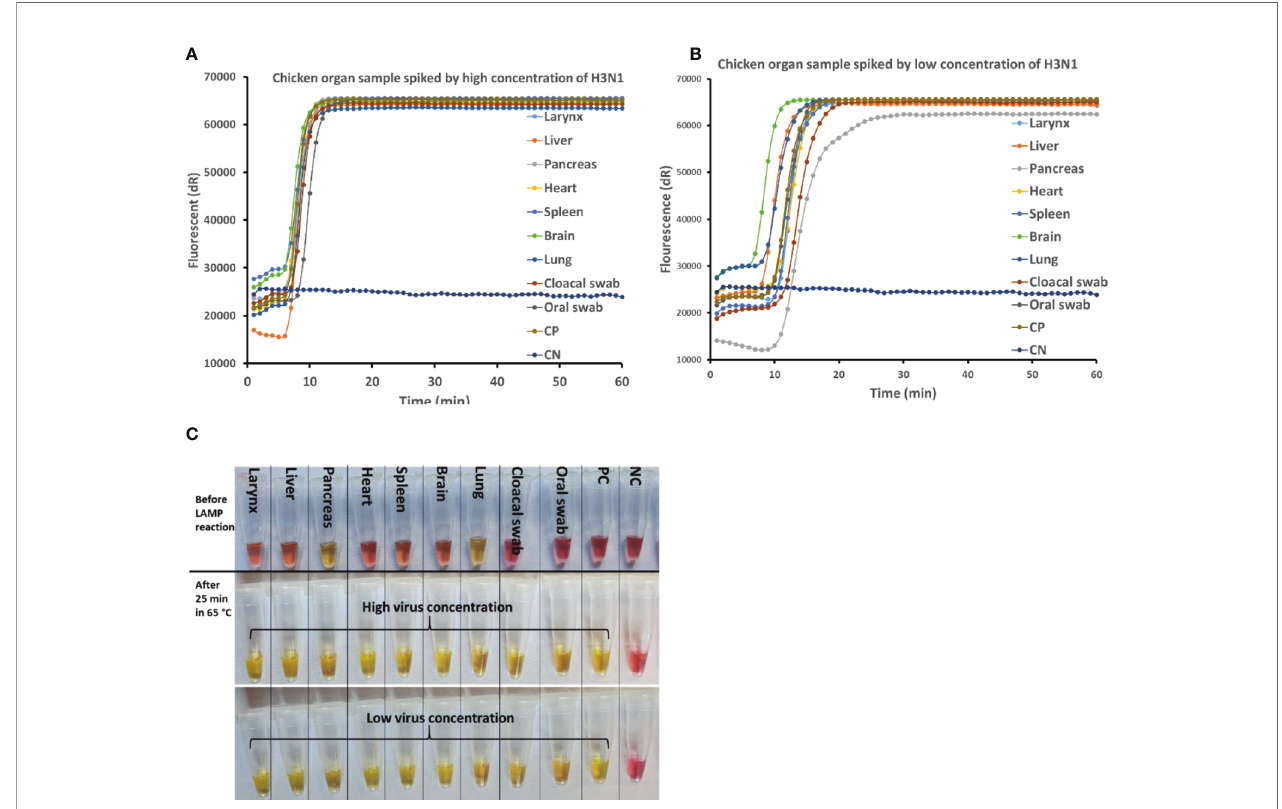
FIGURE 4 | AIV detection in real matrix samples with rRT-LAMP assay and on-site testing method. The real matrix samples (90µL) are spiked with 10 µL of high (10 8.5 EID 50 /mL) and low (10 4.5 EID 50 /mL) concentrations of AIV H3N1. The samples are heat treated at 95°C for 5 min and subjected to rRT-LAMP and on-site testing. rRT-LAMP ampli fi cation curve with high virus concentration (A) and low virus concentration (B) . (C) Before (top) and after LAMP ampli fi cation with high (middle) and low (bottom) concentration of AIV spiked in real matrix samples tested using on-site